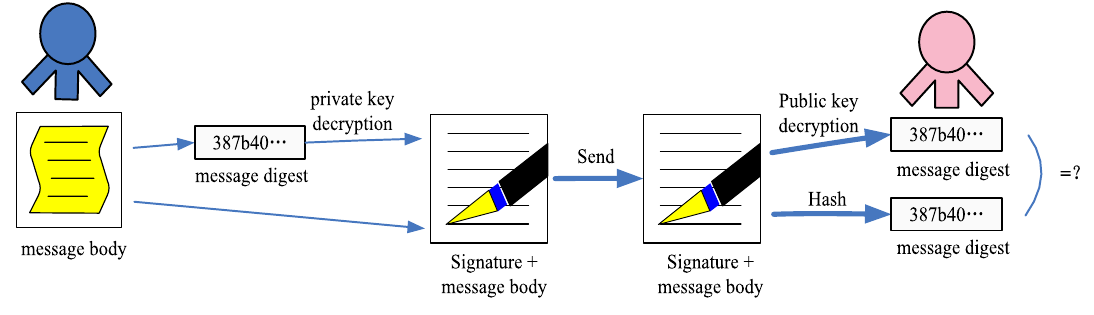
Fig. 5 Digital signature and verification